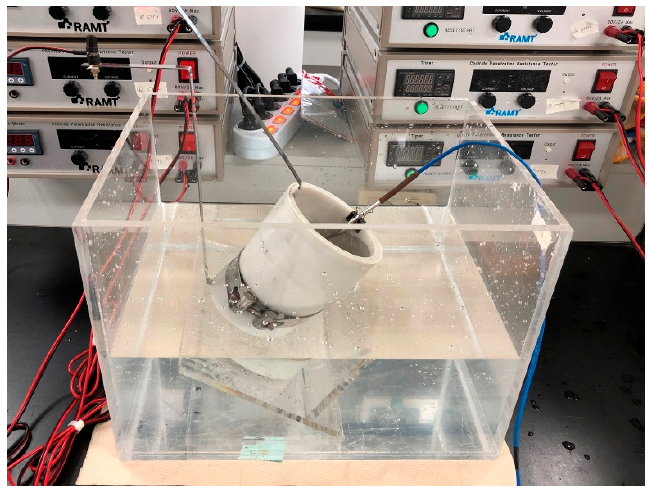
Figure 3. Chloride penetration